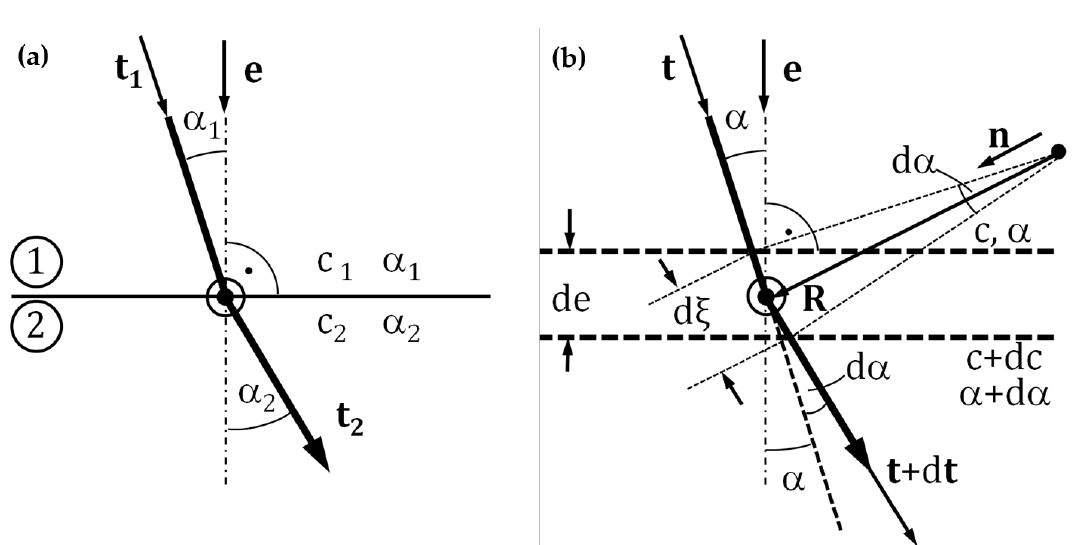
Figure 2. ( a ) A sound wave from direction t at the interface boundary plane of two homogeneous media (1 and 2) with different wave velocities c 1 and c 2 (here: c 2 > c 1 ) is refracted from the angle α 1 to α 2 according to Snell’s Law (34). The vector e is perpendicular to the interface. ( b ) A sound wave